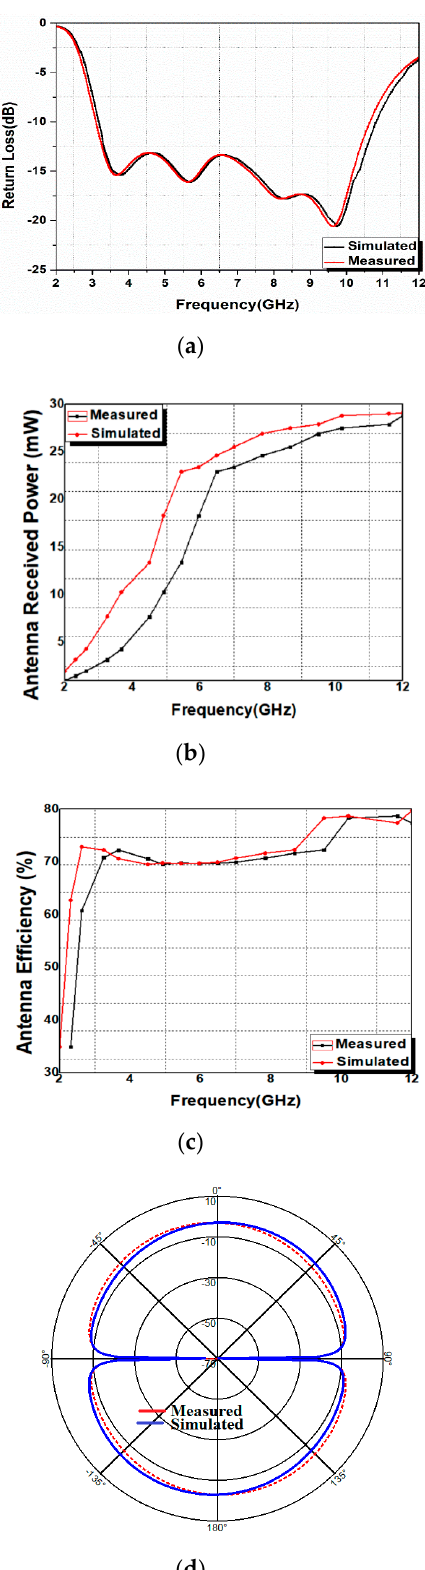
Figure 4. The performance of the proposed antenna with its ( a ) return loss versus frequency, ( b ) antenna received power, ( c ) antenna efficiency, and ( d ) tilt angle of receiver antenna.